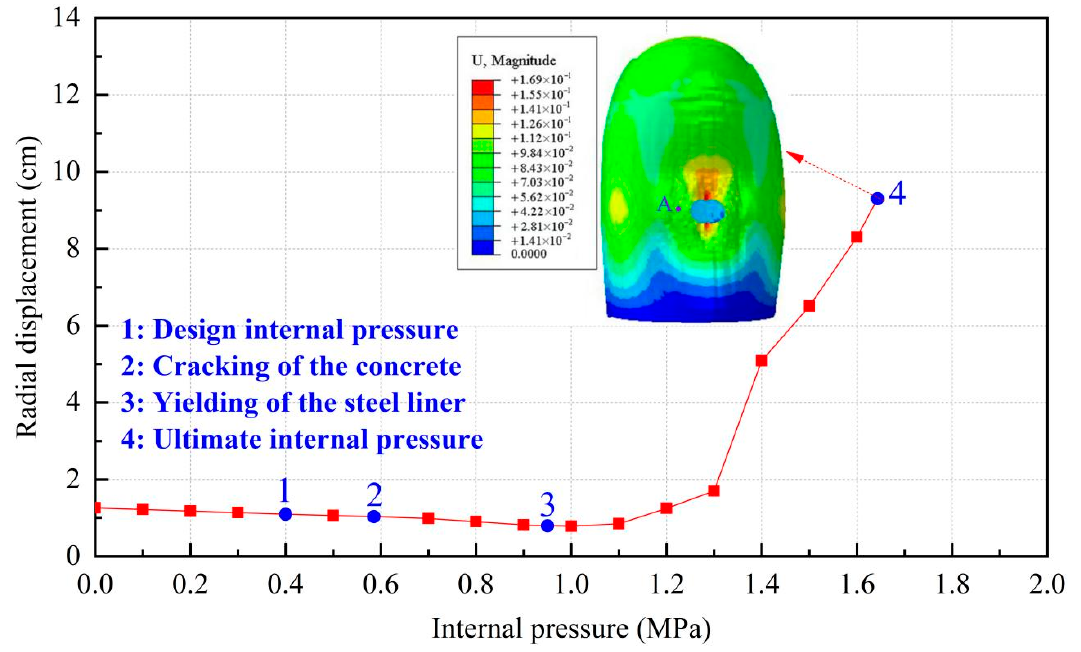
Figure 6. Radial displacement of the conventional containment (point A).